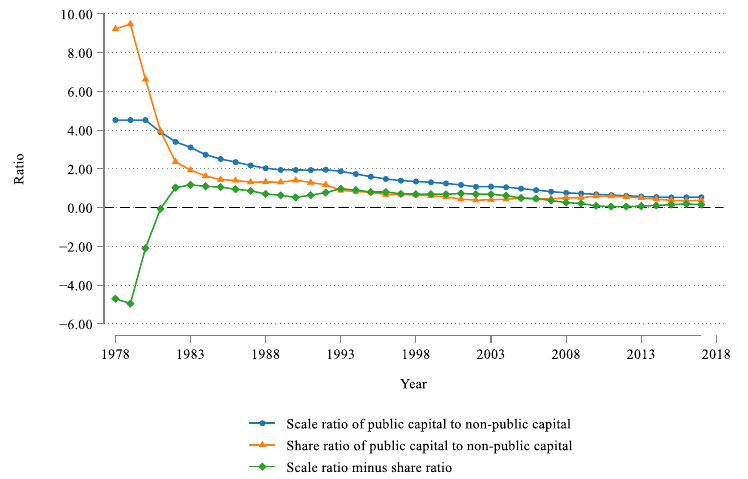
Figure 7. Test of optimal investment condition.